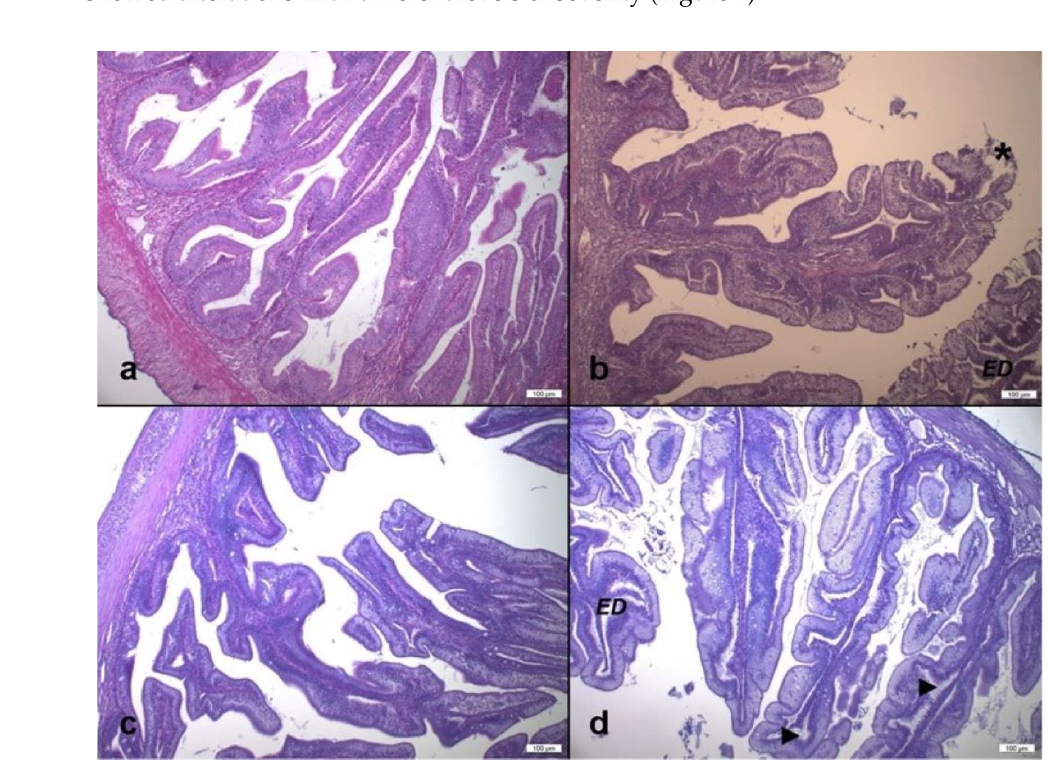
Figure 1. Transverse section of anterior intestine of S. aurata . ( a ) HIM0 group; ( b ) HIM25 group: subepithelial edema that determines the detachment of the epithelium from the lamina propria ( E , D ) and loss of cellular material ( * ) in the intestinal lumen, nuclei are strongly not aligned and supranuclear vacuolations (SNV) are altered; ( c ) HIM35 group: few and moderate gut morphology alterations, nuclei are largely aligned, SNV are moderately altered, few edema and no epithelium detachment. ( d ) HIM50 group: widening of lamina propria and impressive subepithelial edema (arrow head), strong alteration of nuclei position and SNV (H&E, magnification 10 ×